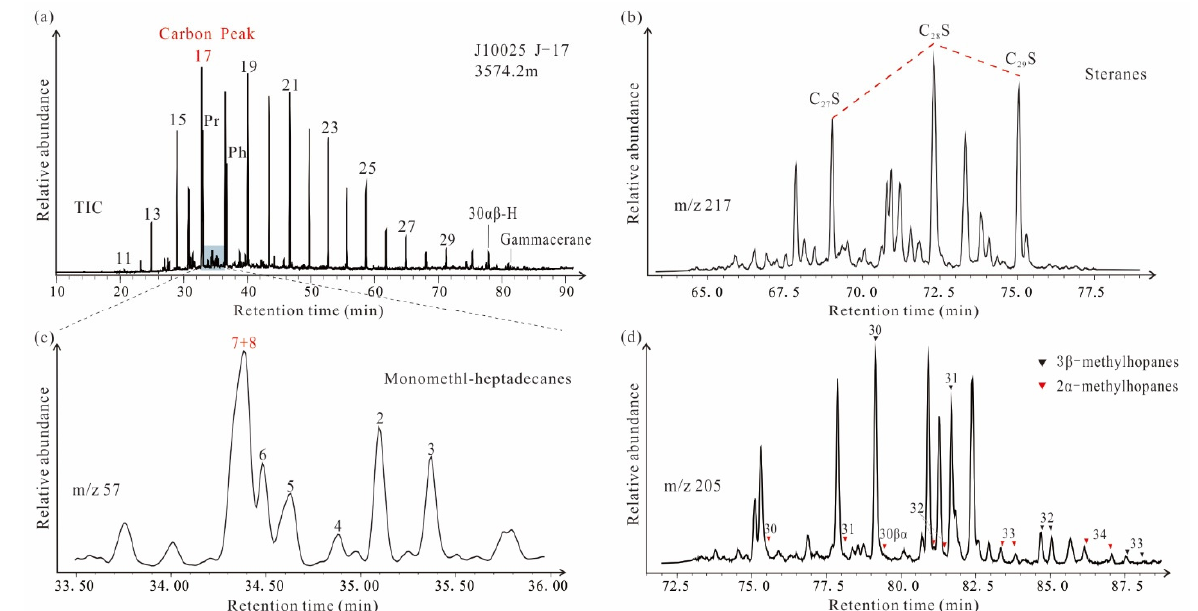
Figure 7. Biomarker chromatograms of cyanobacteria-bearing sample J-17, 3574.2 m. ( a ) Total ion chromatogram of the shale sample. ( b ) Mass chromatograms ( m/z = 217) of the steranes. ( c ) Mass chromatograms ( m / z = 57) of 2–8 monomethyl heptadecanes. ( d ) Mass chromatograms ( m/z = 205) of hopanes.